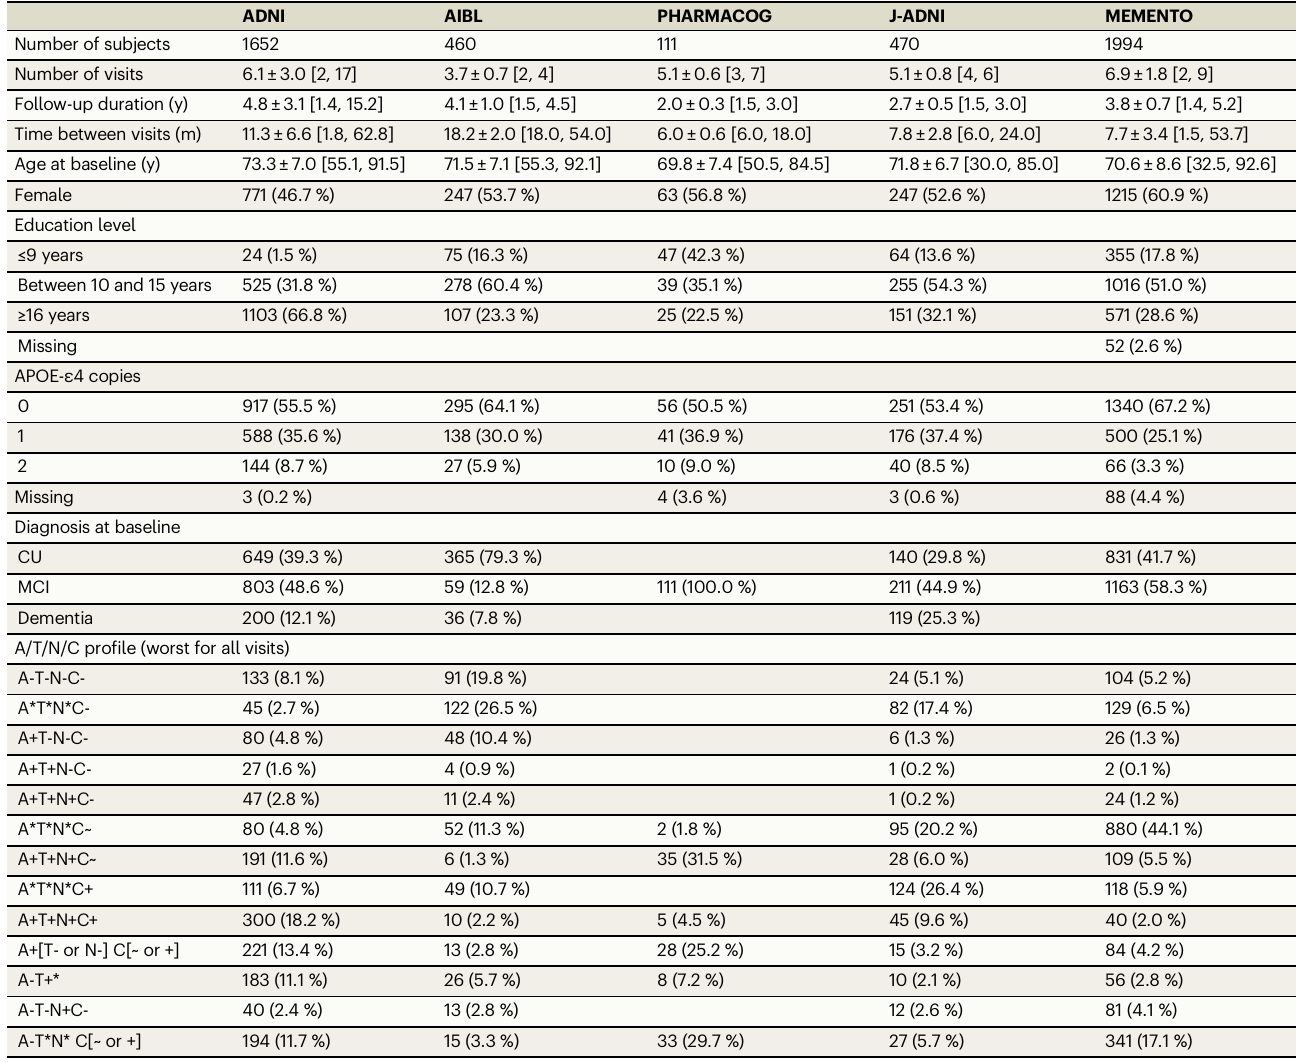
Table 1 | Characteristics of study